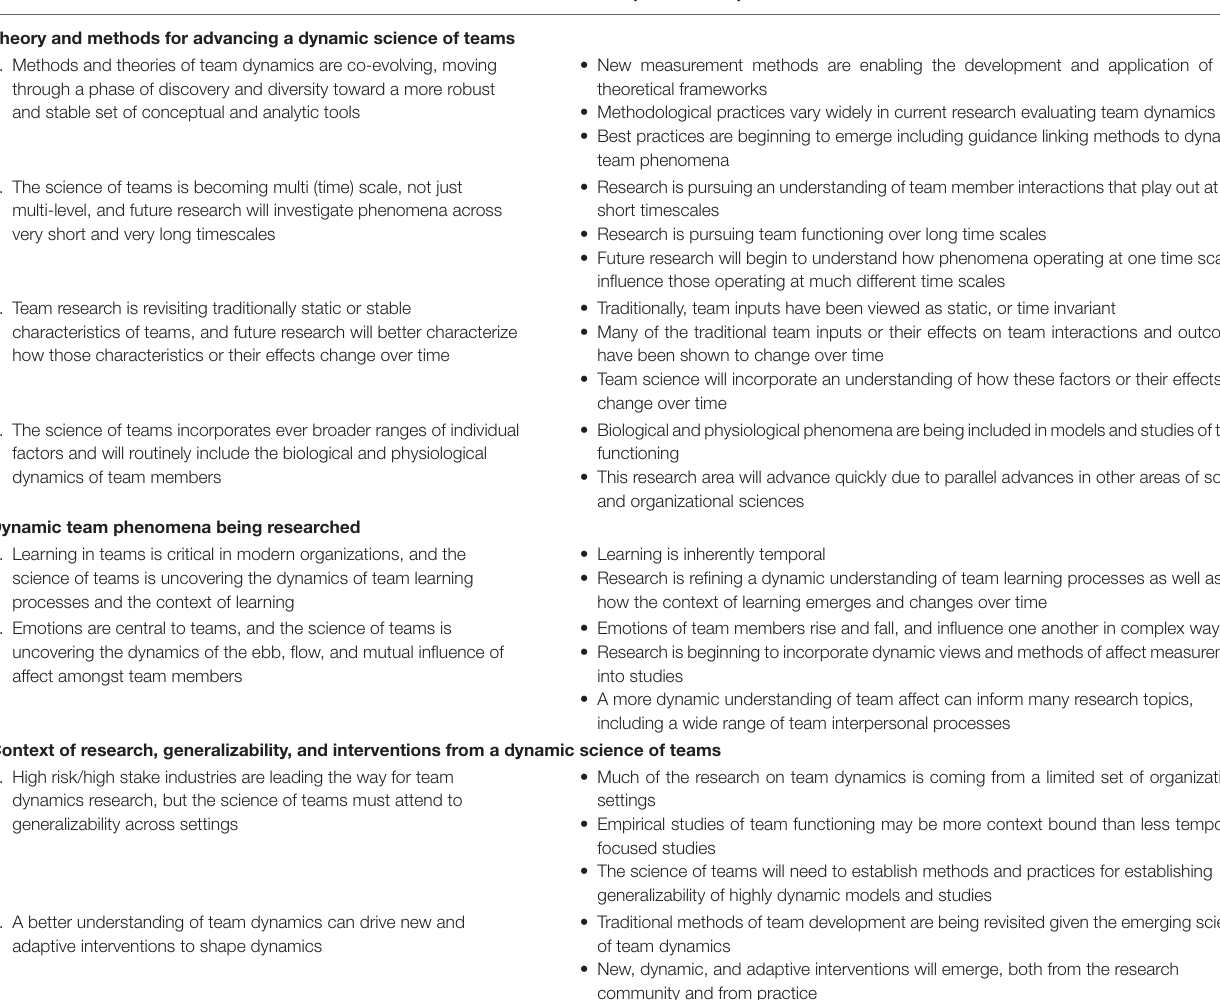
TABLE 1 | Overarching themes across the special issue regarding temporality and the science of teams.